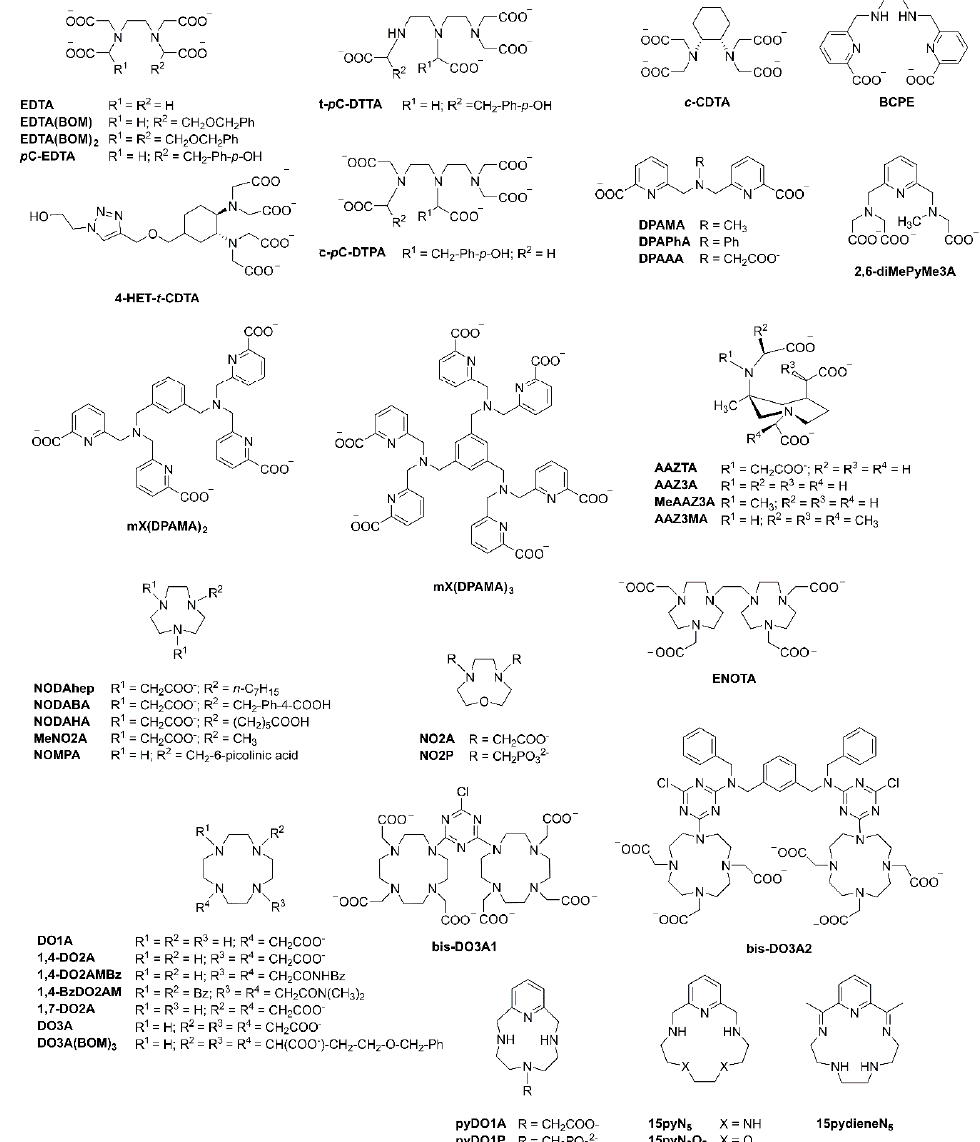
Figure 1. Structures of the organic ligands of the Mn 2+ complexes mentioned in Table 1.